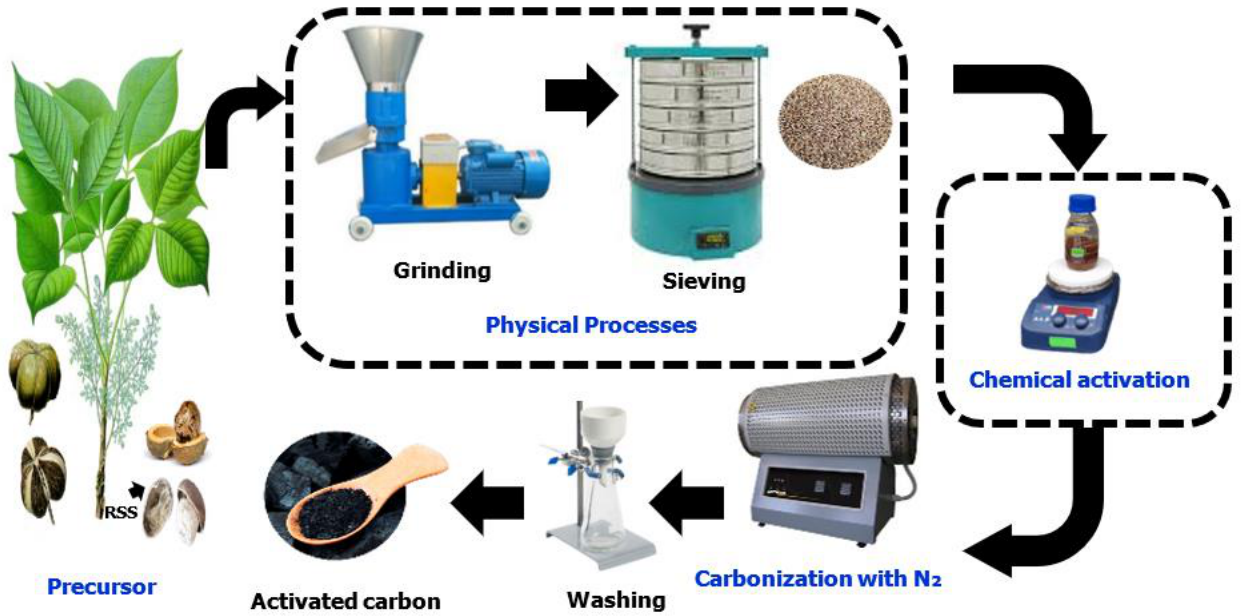
Figure 2. The flowchart of the experimental work.